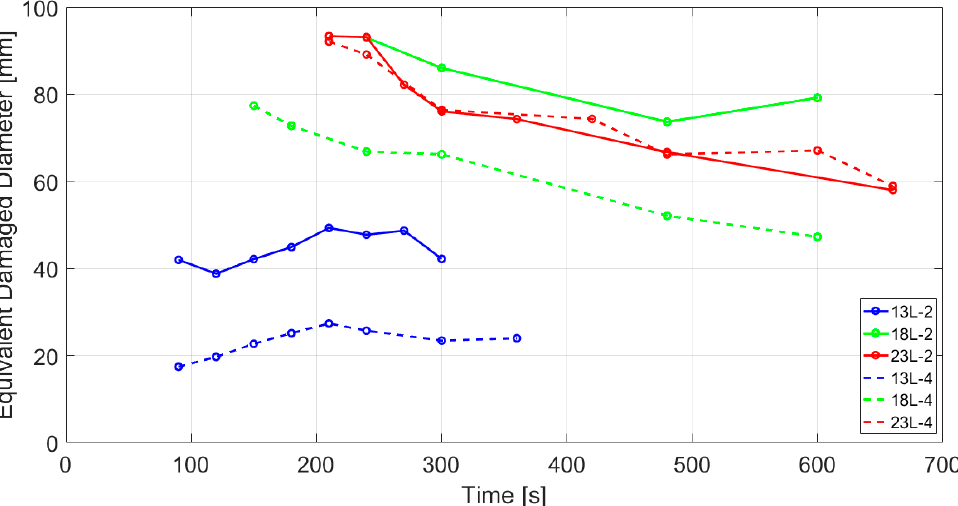
Figure 3. Equivalent damaged diameter area time evolution for the Temperature Difference